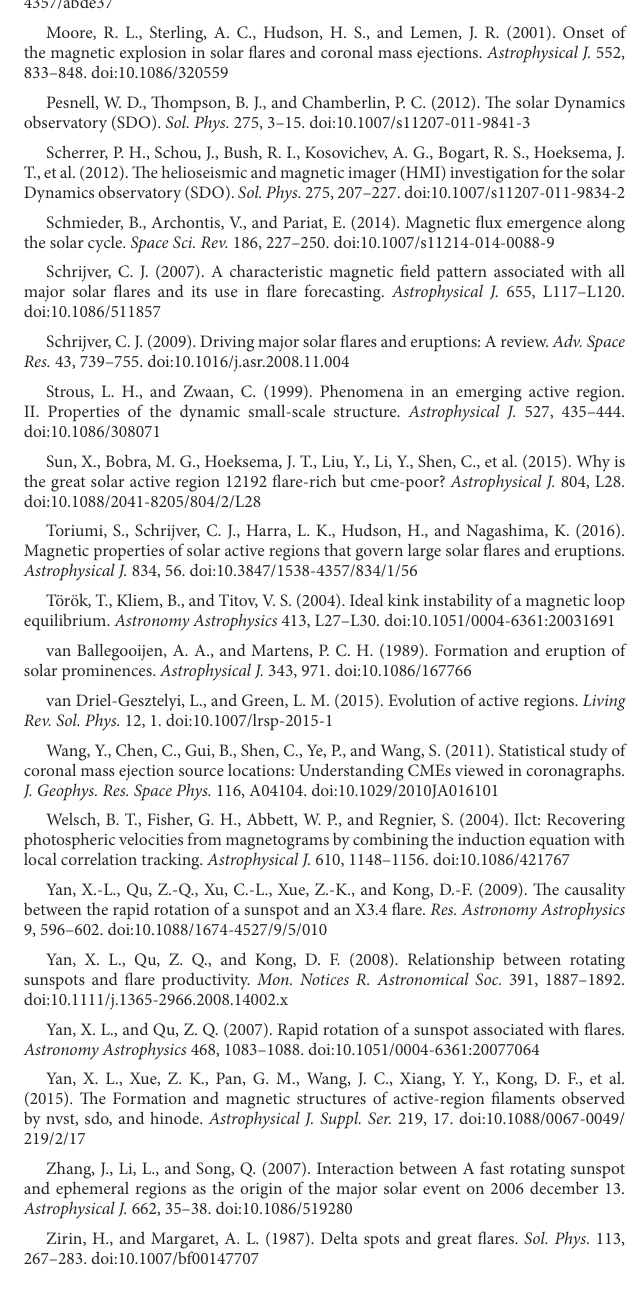
SUPPLEMENTARY VIDEO S1 Online movie 1, generated from a sequence of images similar as in Figure 2 . SUPPLEMENTARY VIDEO S2 Online movie 2, generated from a sequence of images similar as in Figure 3 .